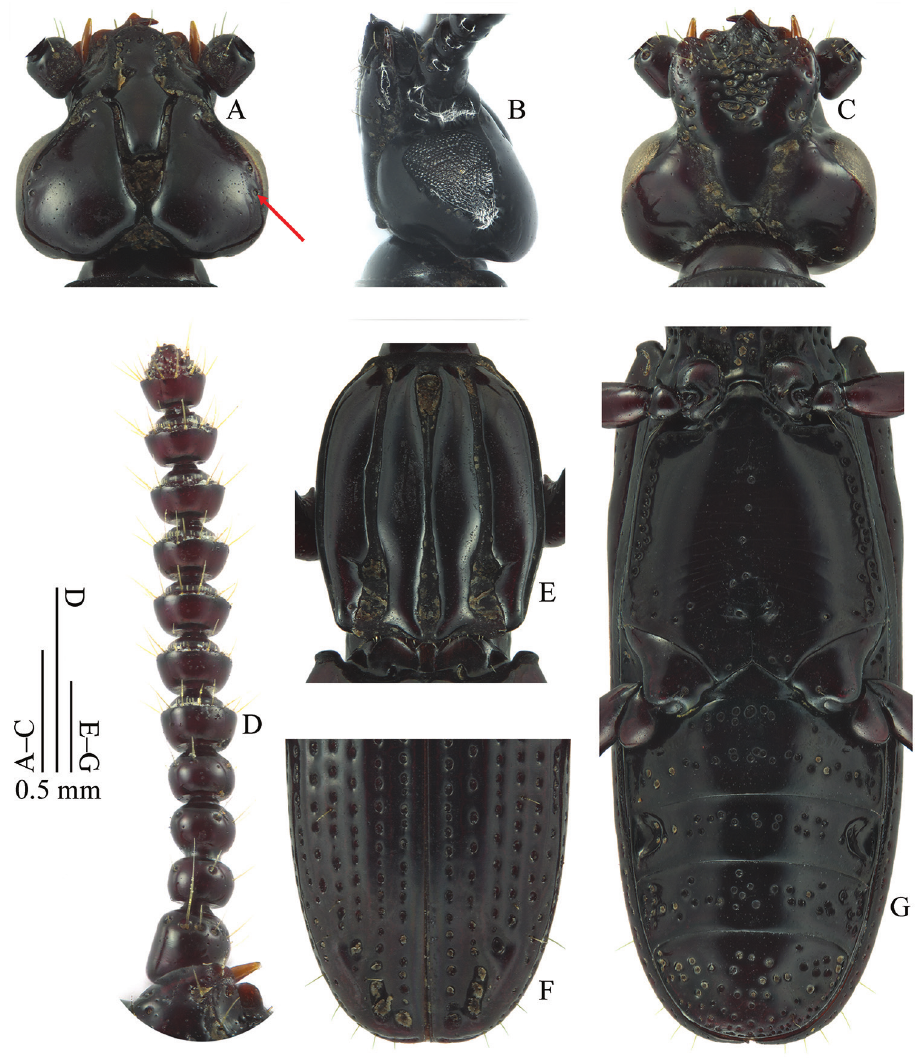
Figure 3. Omoglymmius ( s. str. ) wukong sp. n. (paratype, ♂ ). A–C head D antenna E pronotum F , elytral apex G metasternum & abdomen. ( A, E, F dorsal view B left lateral view C, D, G ventral